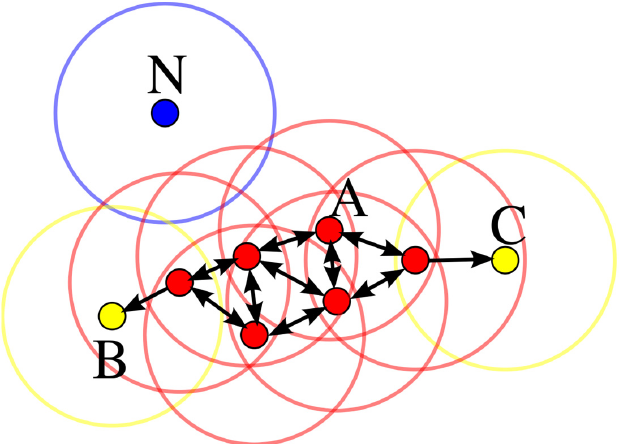
Figure 1. DBSCAN clustering algorithm, shared from [27] (CC BY ‐ SA 3.0). N is an outlier, A is a core point, B and C are reachable from A but not core points. The radius of all circles (hyperspheres in an n ‐ dimensional space) is ε .